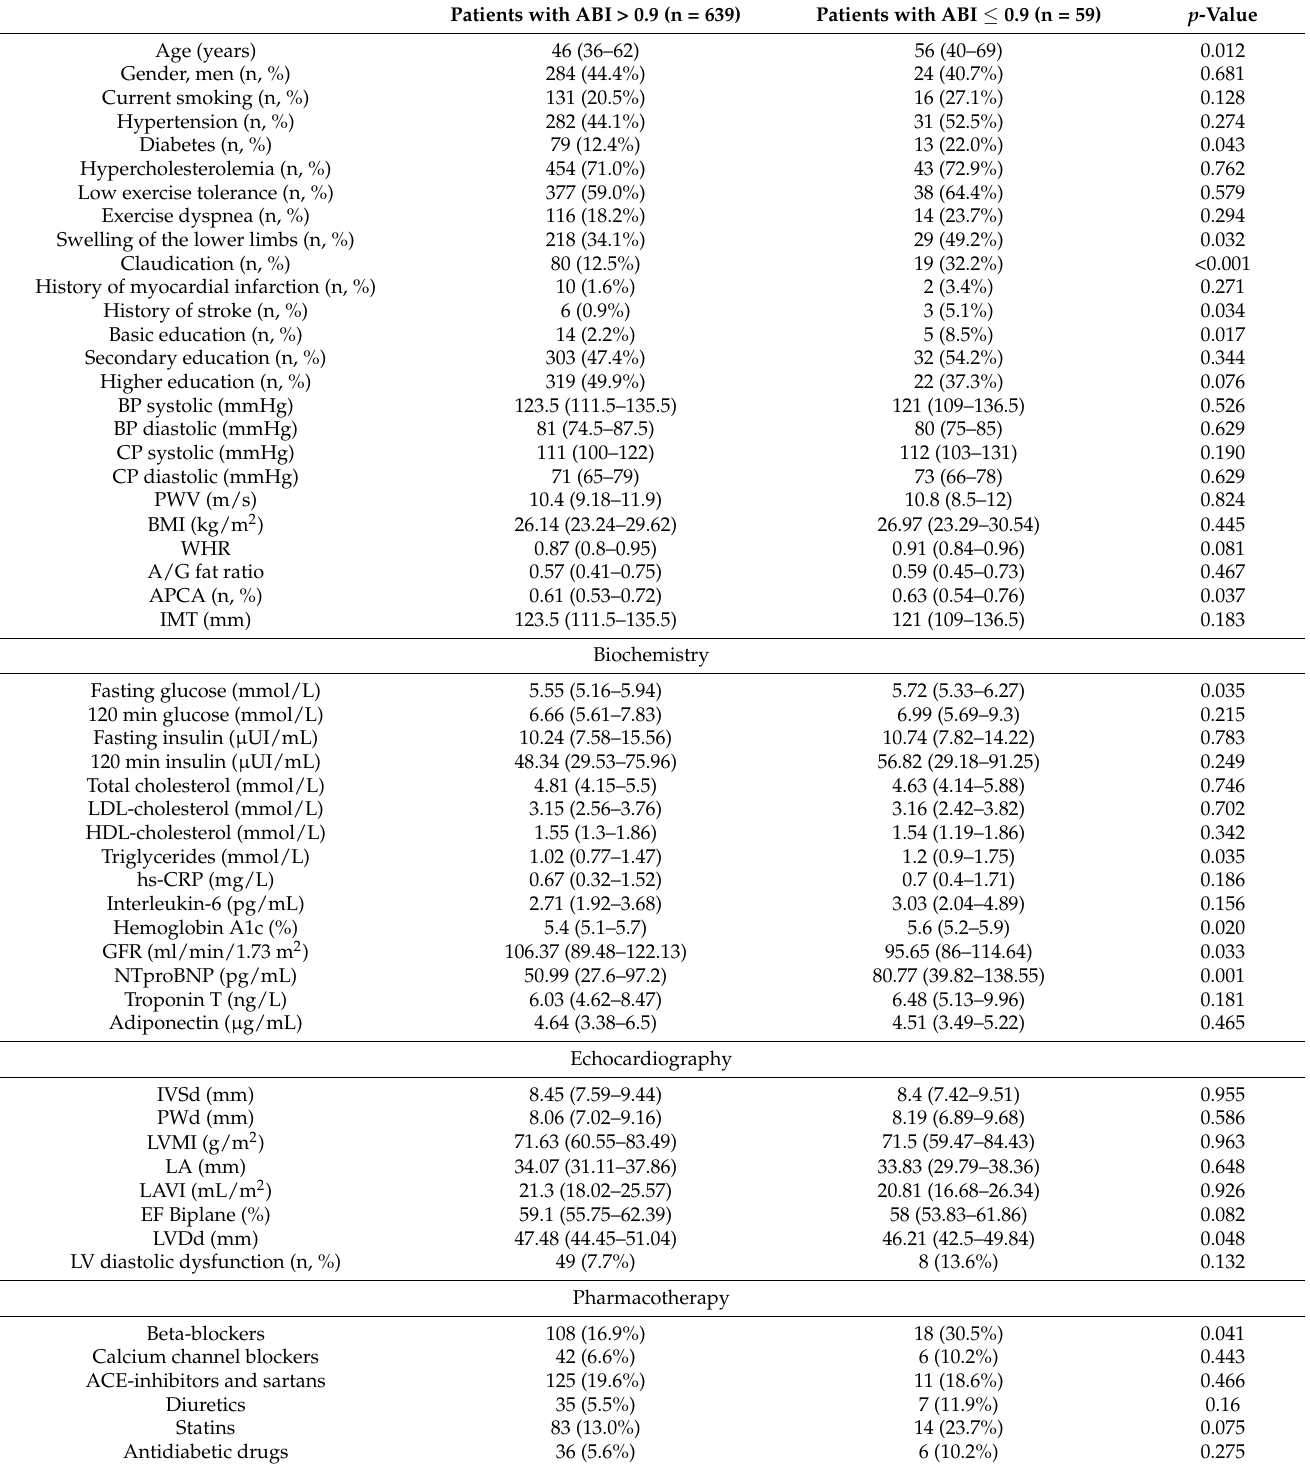
Table 4. Characteristics of the study group depending on the ABI ≤